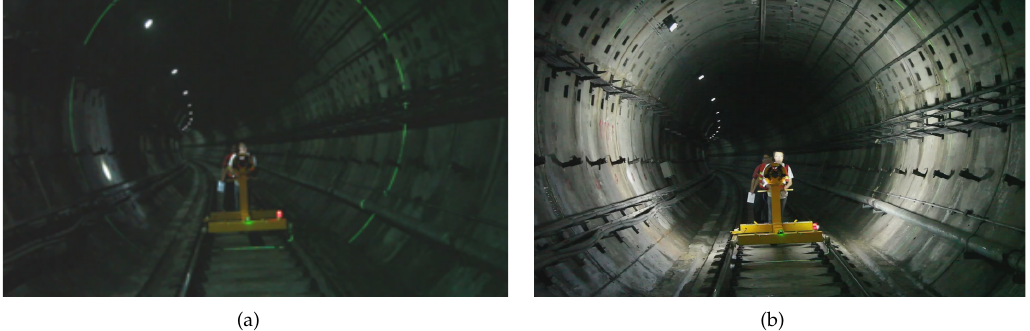
Figure 2. Integrated acquisition during inspection: ( a ) Mode of acquiring surface images and ( b ) mode of acquiring profile